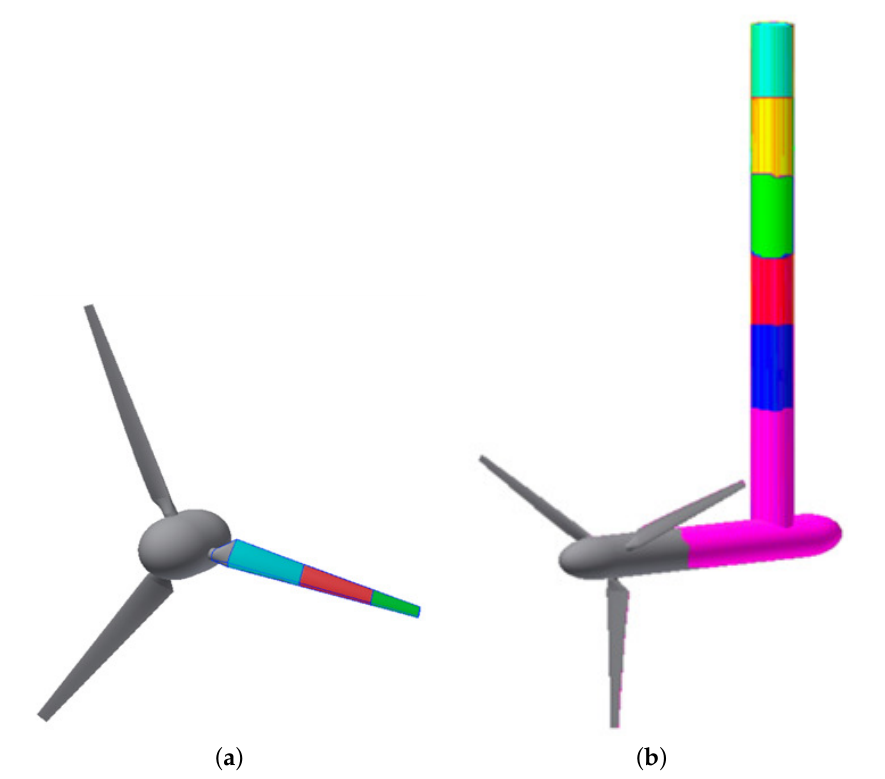
Figure 1. HAHT geometry ( a ) rotor (blades and hub) and ( b ) support structure. Table 1. Summary of HAHT